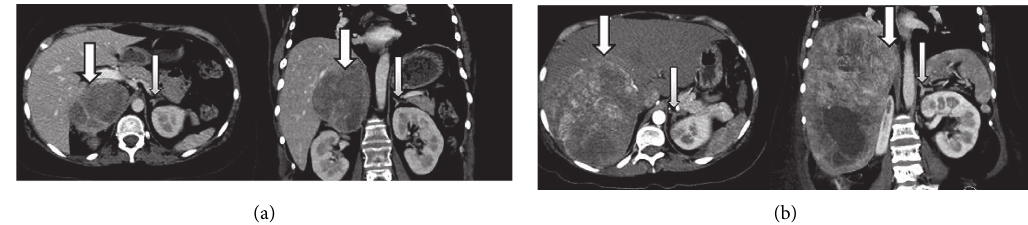
Figure 1: High-resolution, contrast abdominal CTscan, at diagnosis (a) and 16 months after right adrenalectomy (b). (a) Axial and coronal views showing a large, heterogeneous right adrenal mass and an atrophic left adrenal gland. (b)Axial and coronal views showing a large, heterogeneous hepatic mass and a somewhat hypoplastic left adrenal